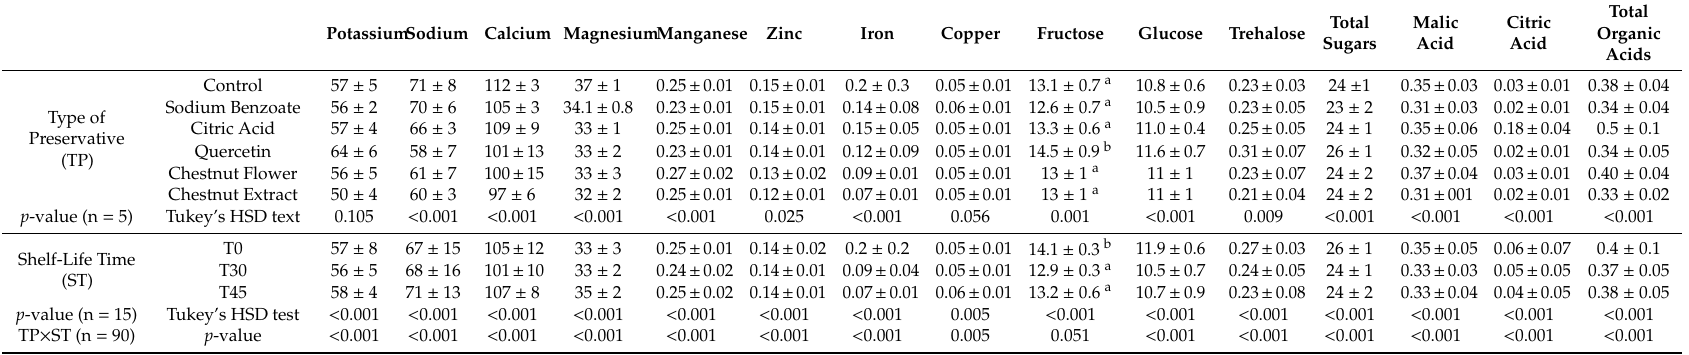
In each row, for the type of preservative (TP) and shelf-life time (ST), di ff erent letters mean statistical di ff erences among the preservative type or shelf-life time, with an overall significance level of 0.05. The presented standard deviations were calculated from results obtained under di ff erent operational conditions, and, should therefore not be regarded as a measure of precision, rather as the range of the recorded